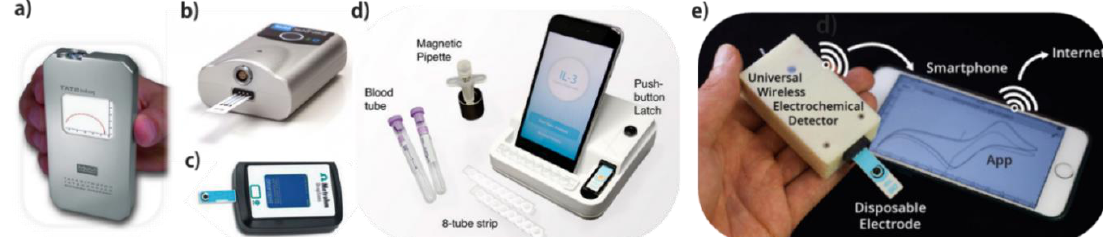
Figure 1. Examples of hand-held electrochemical readers as ( a ) PocketStat (IVIUM Technologies ® ), ( b ) EmStat (PalmSens ® ) and ( c ) DropStat (DropSens ® ); ( d ) integrated biosensor for Sepsis diagnosis (adapted from reference [13] with permission of American Chemical Society); and, ( e ) universal wireless electrochemical detector (UWED). Reproduced with permission from [14].